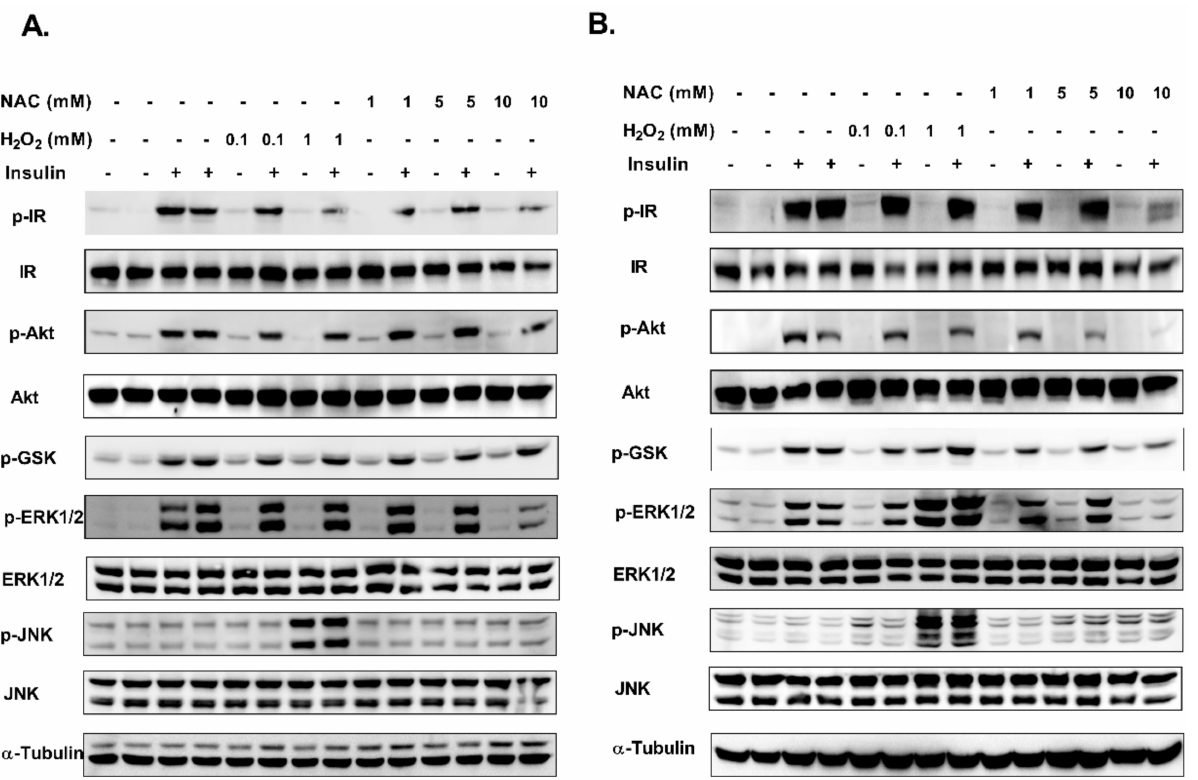
Figure 5. NAC reduced insulin-induced phosphorylation of signaling proteins in 3T3-L1 adipocytes and L6 myotubes. 3T3-L1 ( A ) and L6 ( B ) were treated with H 2 O 2 or NAC for 24 h ( B ) followed by incubation with insulin (100 nM) for an additional 10 min. Western blot analysis of proteins involved in insulin signaling pathway was performed. Representative blot of 3 independent experiments is